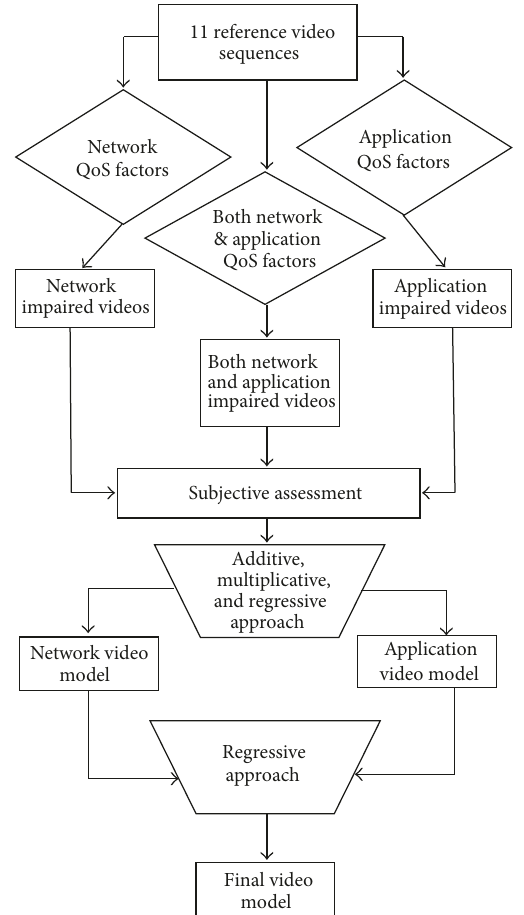
Figure 2: Methodology for building the video